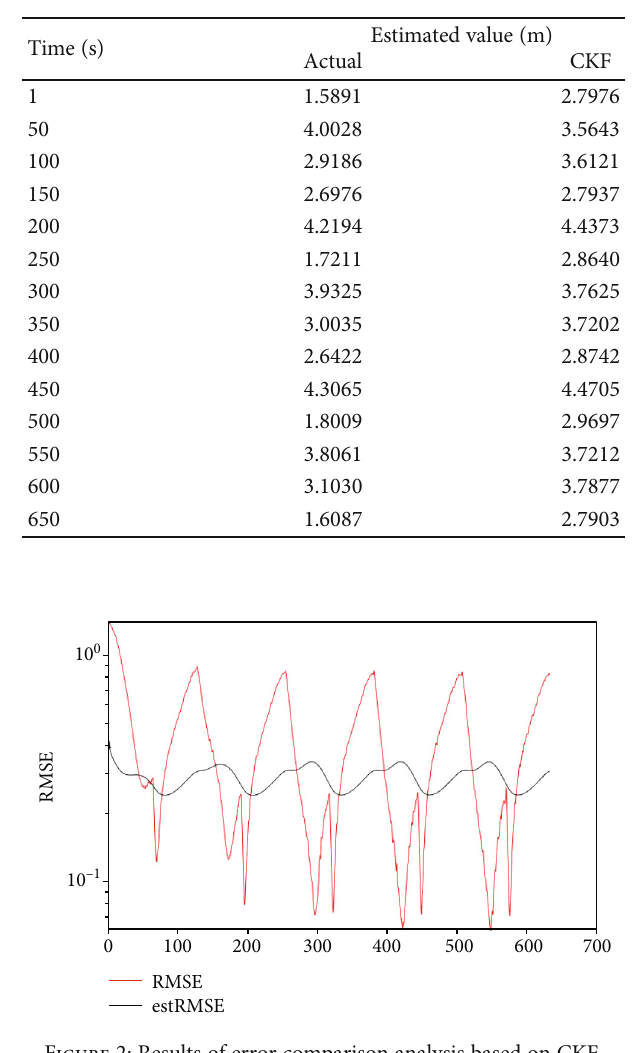
Figure 1: Comparison of state estimates based on CKF. Table 1: Comparison of actual and state estimates.